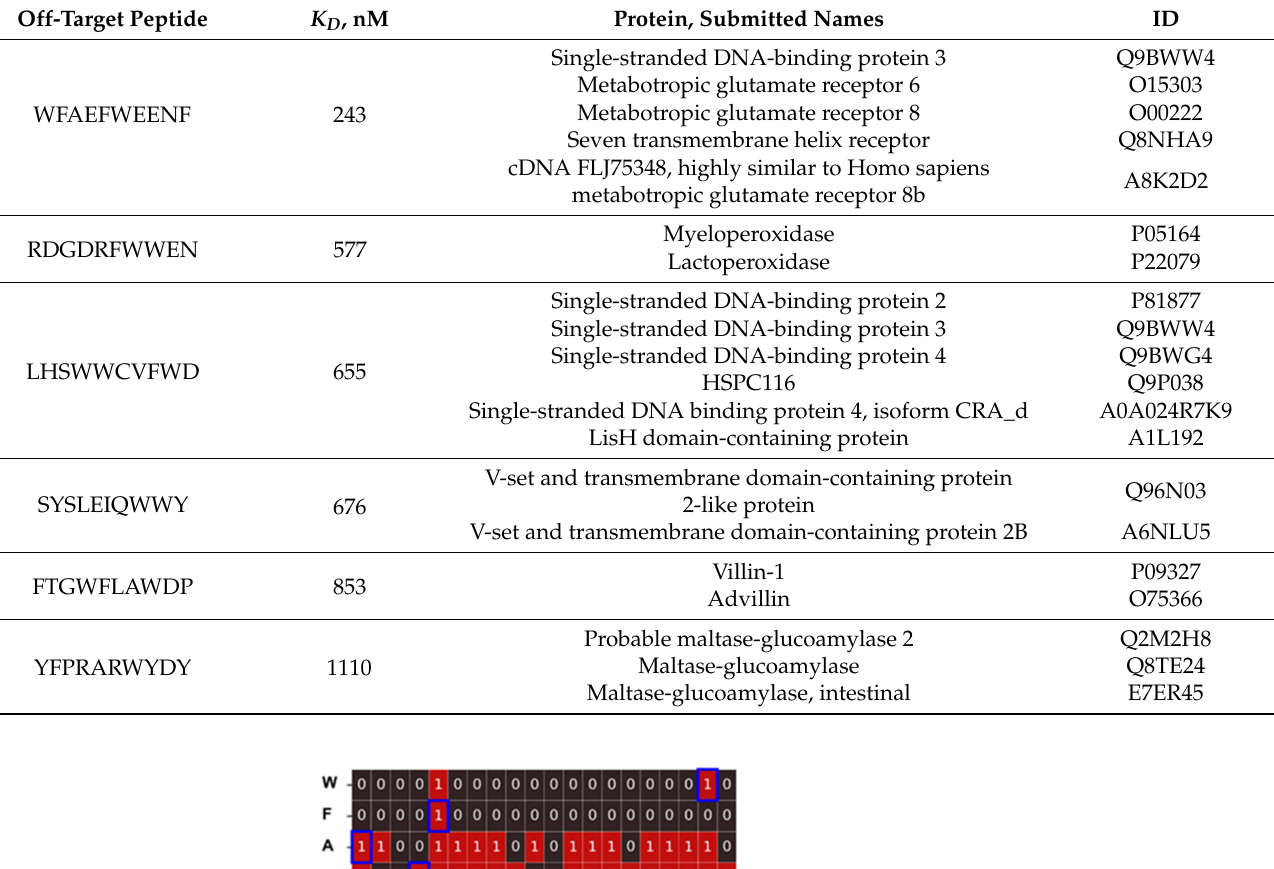
Table 2. Off-target peptides for RTX with a dissociation constant ≤ 1000 nM with their containing proteins.